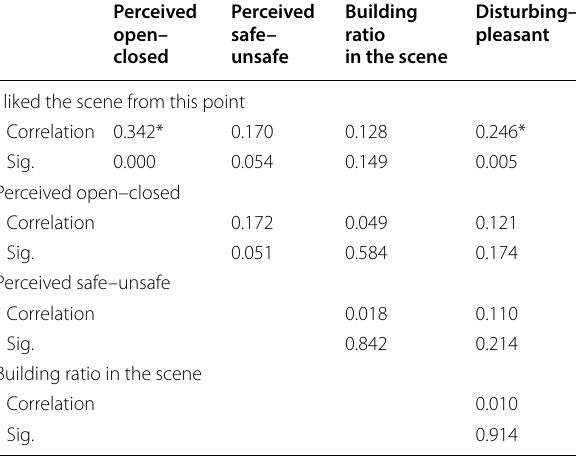
Table 6 Correlation results of selected